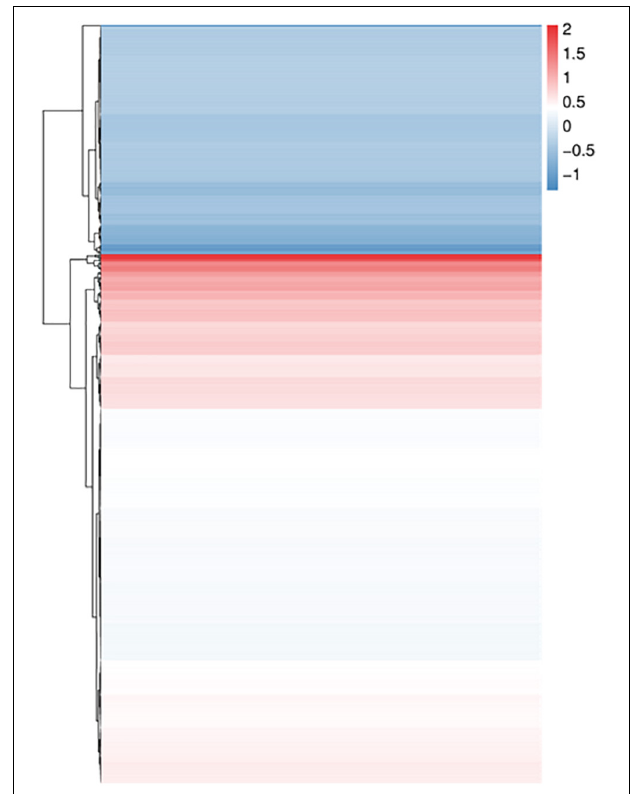
FIGURE 2 | Cluster analysis of differential proteins between the CAA and Lys-Leu treatments. Blue color means downregulation of differential proteins, and red color means upregulation of differential